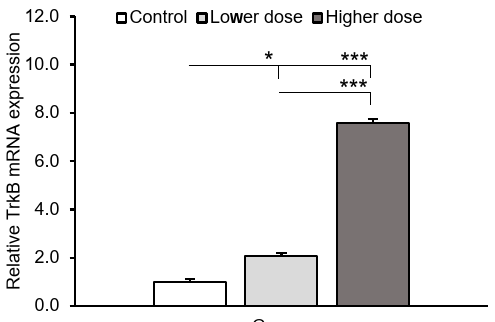
Figure 1. Brain-derived neurotrophic factor (BDNF) mRNA expression ( a ) and peptide concentration ( b ) (mean ± SEM) in the hippocampal CA1 field of sheep infused with the lower (20 μ g in total) and higher (100 μ g in total) dose of kynurenic acid into the third ventricle of the brain. Significance of differences: * p < 0.05, *** p < 0.001.